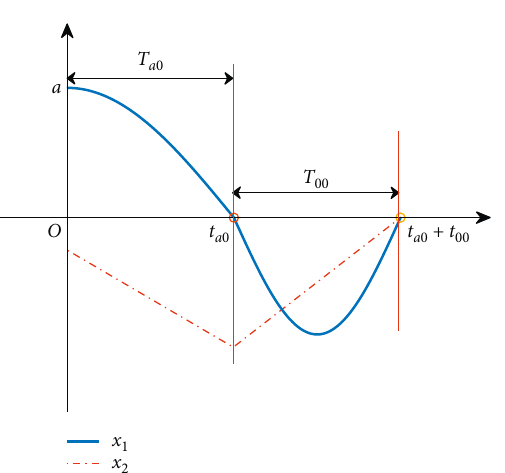
Figure 3: Trajectory of STS in the convergence procedure.